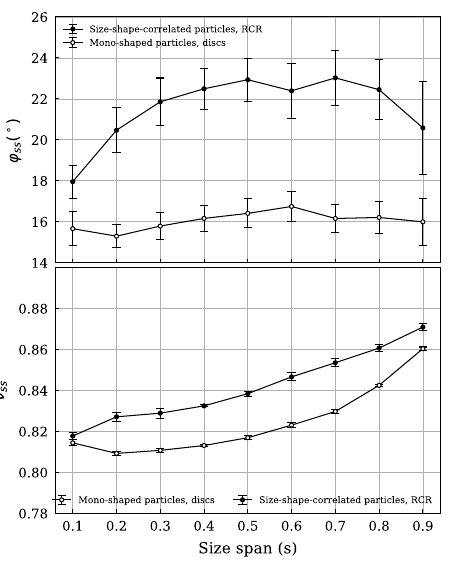
Figure 4. Comparison of steady-state angle of internal friction ' ⌫ ss and packing fraction ss as functions of the PSD-size-span s of the two di ↵ erent series: Series 1 composed of mono-shaped (discs) particles, and Series 2 composed of particles with size and shape correlated (RCRs). Values shown are averages of data for strains over 35% ( steady state, see Figure 6). The error bars ⇠ capture the scatter of the readings (see Figure 6) and indicate the standard